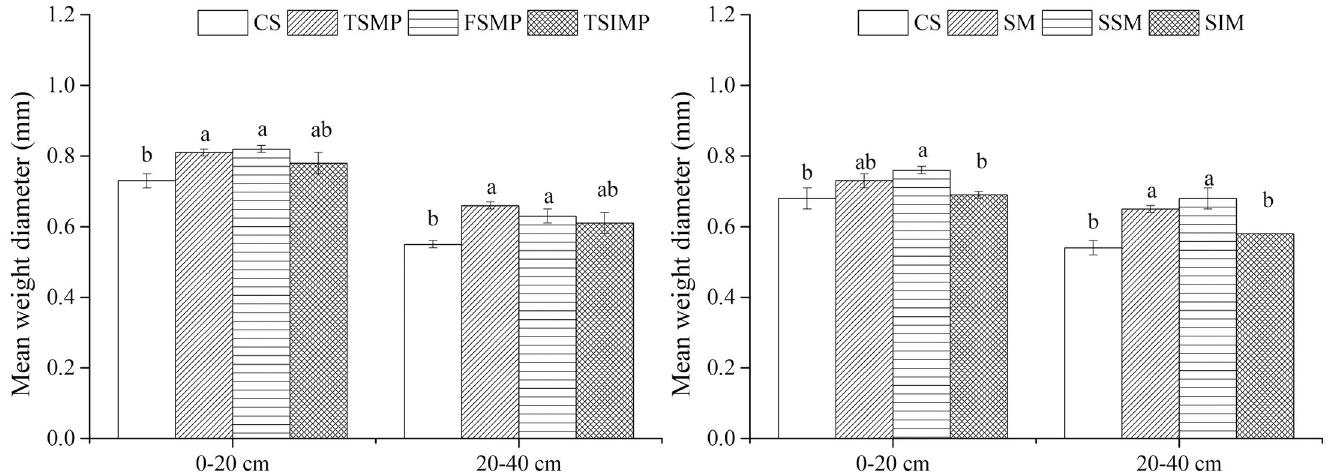
Fig 6. Effects of soil mixing on the MWD of Albic soil. Different lowercase letters indicate significant differences between samples ( P < 0.05). Bars represent standard errors (n = 3).